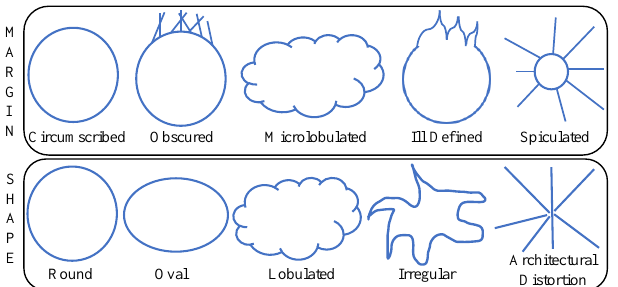
Figure 1. The morphological division of the breast cancer shapes according to the growth pattern